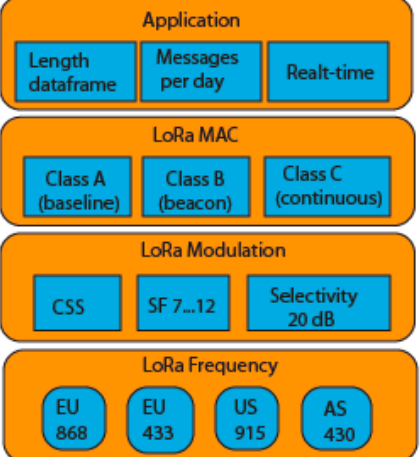
Figure 15. LoRa class on the basis of LoRa MAC layer operation.